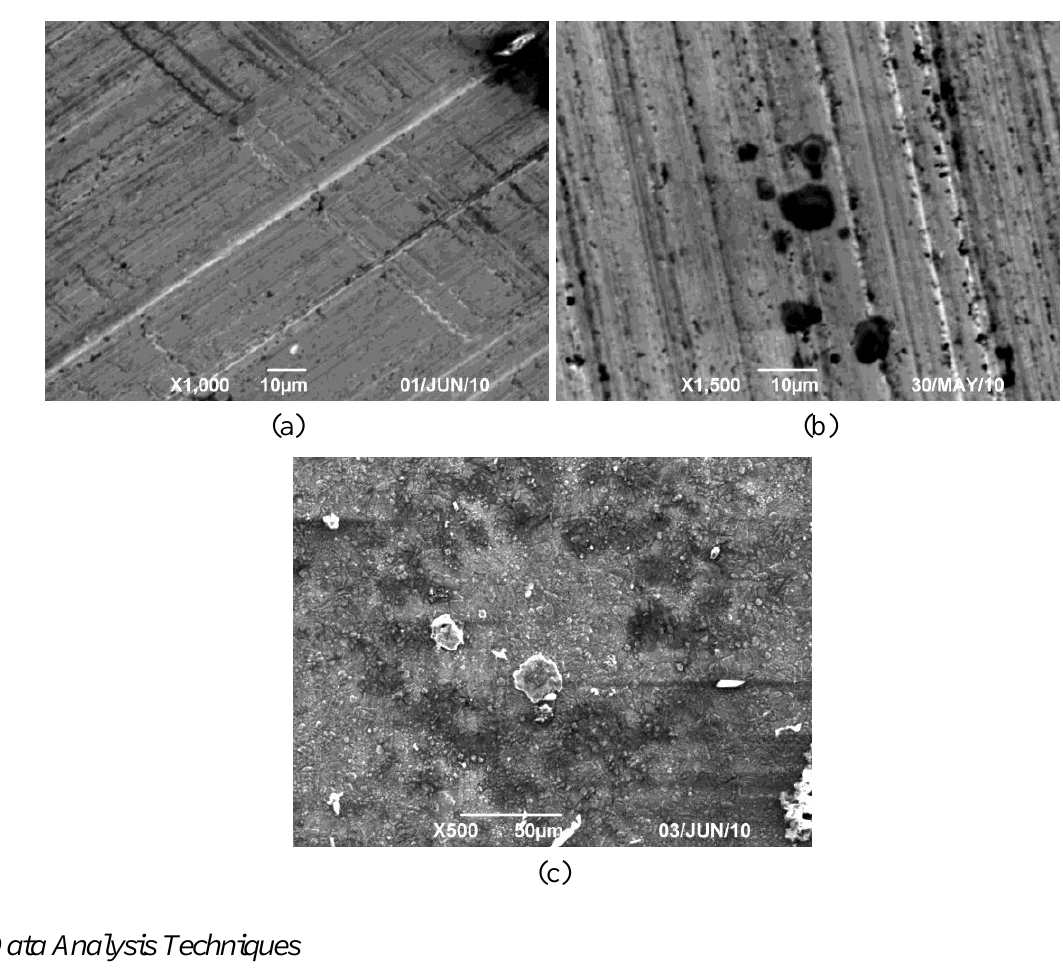
Figure 10. SEM surface micrograph showing defects of the uncoated and multilayers coated carbide inserts. (a) surface groove (K68, sample 2); (b) high surface roughness (K68, sample 4); (c) droplets of coating spallation and delamination (GC415, sample